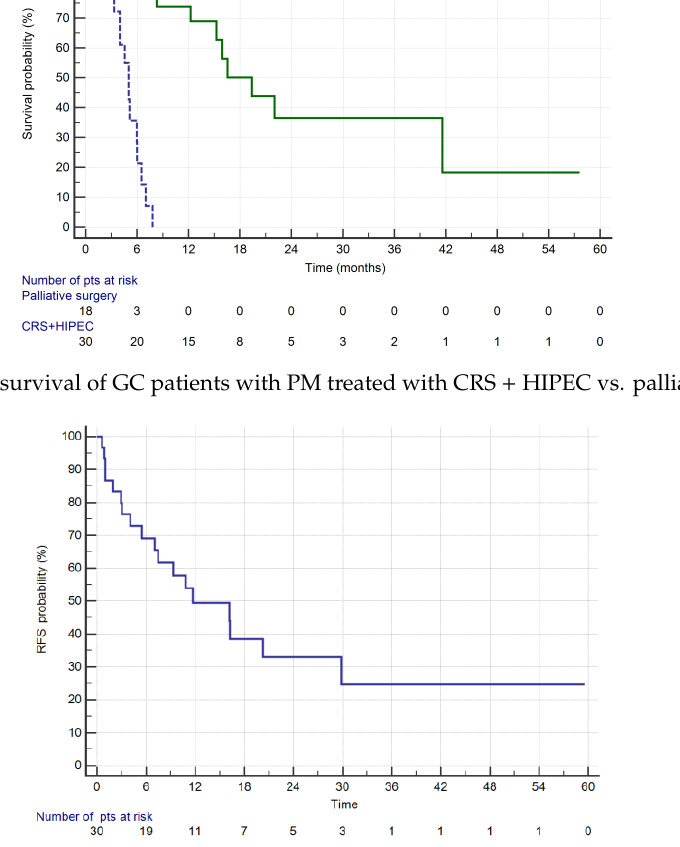
Figure 3. Recurrence free survival of GC patients with PM treated with CRS + HIPEC.